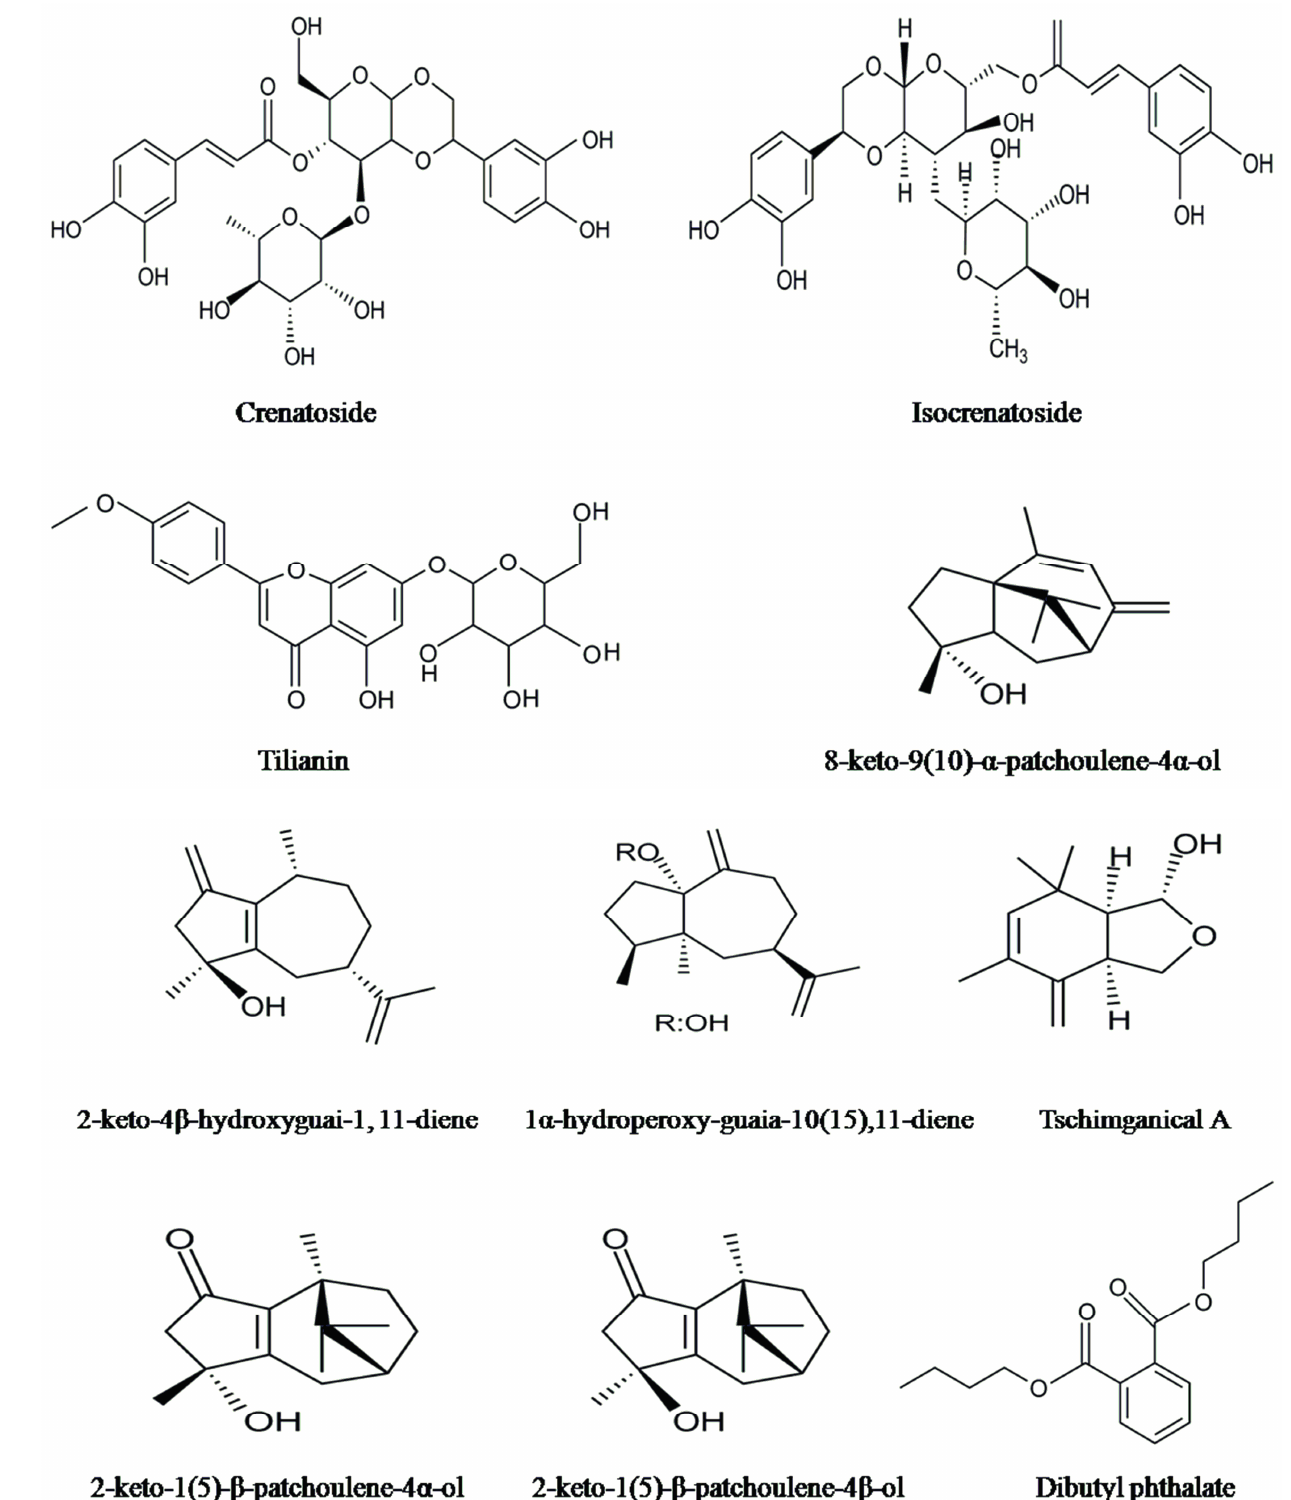
Figure 2. The structures of some of the non-volatile chemical